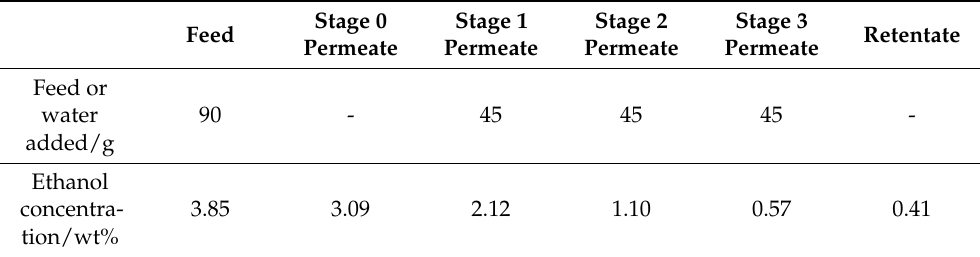
Table 5. Amount of water added and ethanol concentration during different stages of discontinuous diafiltration of naproxen crystal suspension.